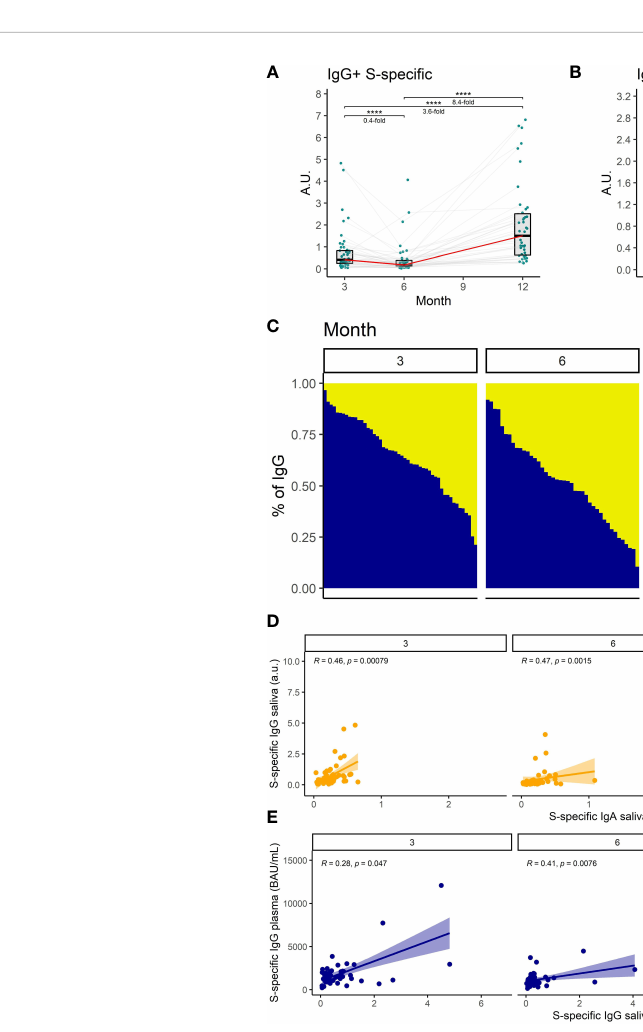
FIGURE 2 The dynamics of S1-speci fi c antibody response in saliva after the initial and booster doses of mRNA vaccine. S1-speci fi c (A) IgG, (B) IgA, levels in the saliva of vaccinated individuals for months 3, 6, and 12 after the initial vaccination. The red line connects the median values of each time point. Fold change was calculated as a ratio of the medians of compared time points. (C) Relative proportions of IgA and IgG isotypes among the S1-speci fi c antibodies in the saliva of vaccinated individuals. (D) Correlations between the salivary S1-speci fi c IgG and IgA for different time points. (E) Correlations between the plasma and salivary S1-speci fi c IgG for different time points. Differences between the groups were assessed using the Wilcoxon test with Holm ’ s correction for multiple testing. The strength of correlations was assessed by Spearman ’ s correlation test. *p < 0.05, **p < 0.01, ***p < 0.001, ****p <